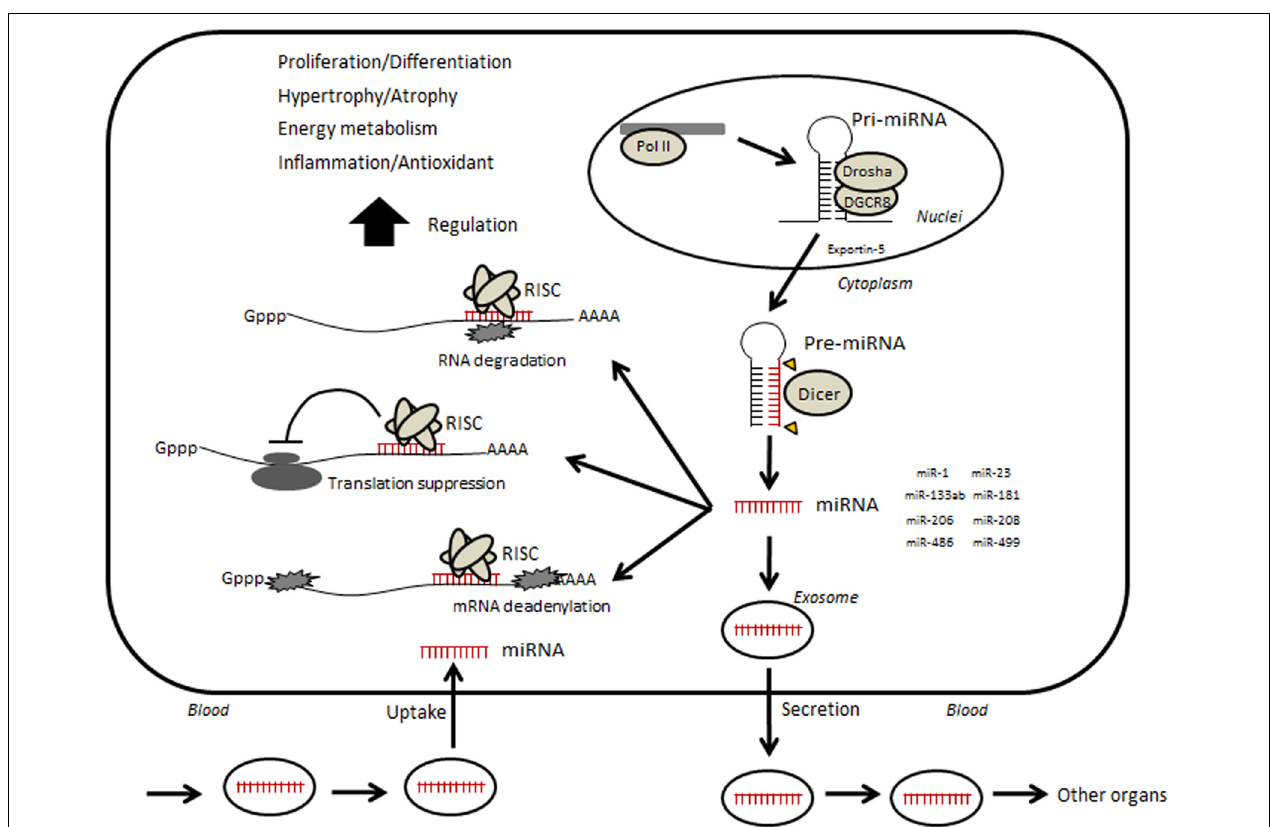
FIGURE 1 | Hypothetical illustration of relevance between circulating microRNA and skeletal muscle. Small non-coding RNAs are transcribed by RNA polymerase II (Pol II)-producing long primary transcripts (pri-miRNAs), which are then cleaved into stem-loop pre-miRNAs by the microprocessor, which includes the RNase III enzyme Drosha and DiGeorge syndrome critical region gene 8 (DGCR8). The pre-miRNA is subsequently transported from the nucleus to the cytoplasm by Exportin-5 and further cleaved by the enzyme Dicer into